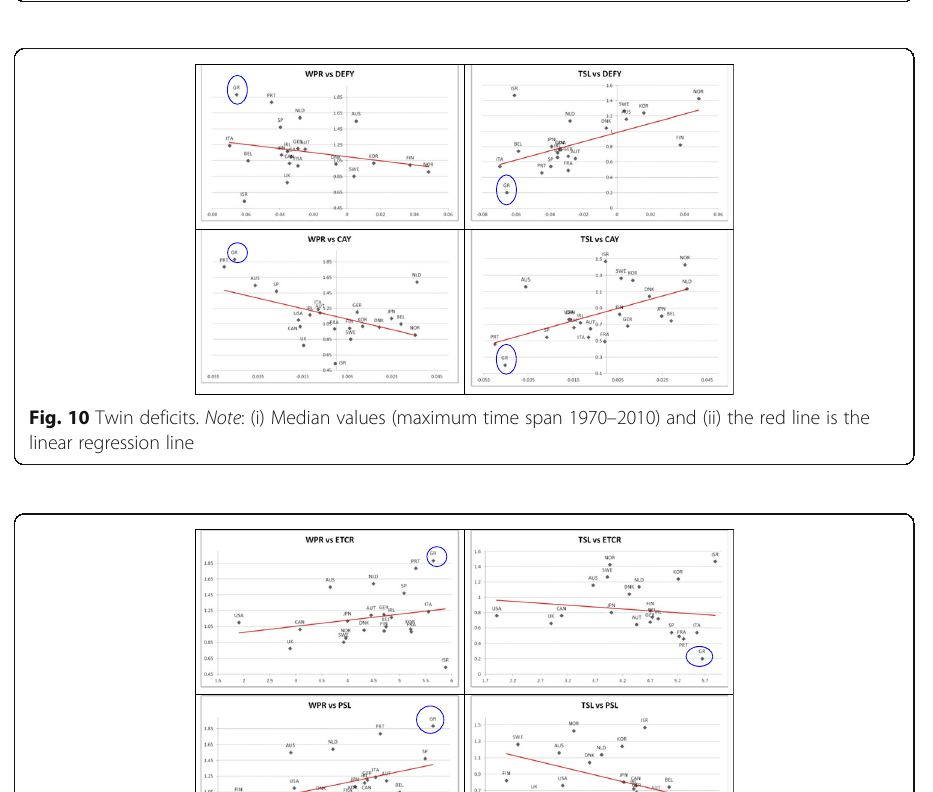
Fig. 9 Public finances. Note : (i) Median values (maximum time span 1970 – 2010) and (ii) the red line is the linear regression line